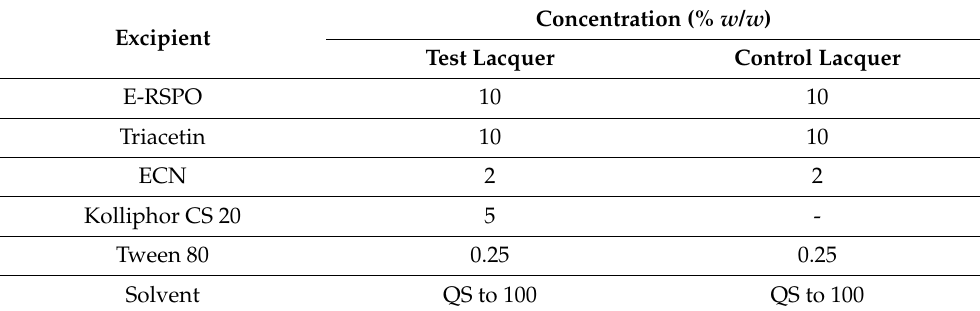
Table 8. Composition of the final optimized test and control